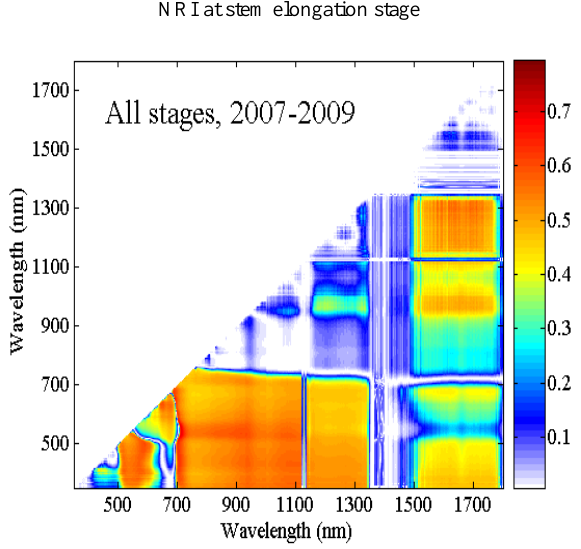
Figure 5. Contour diagram showing the coefficient of